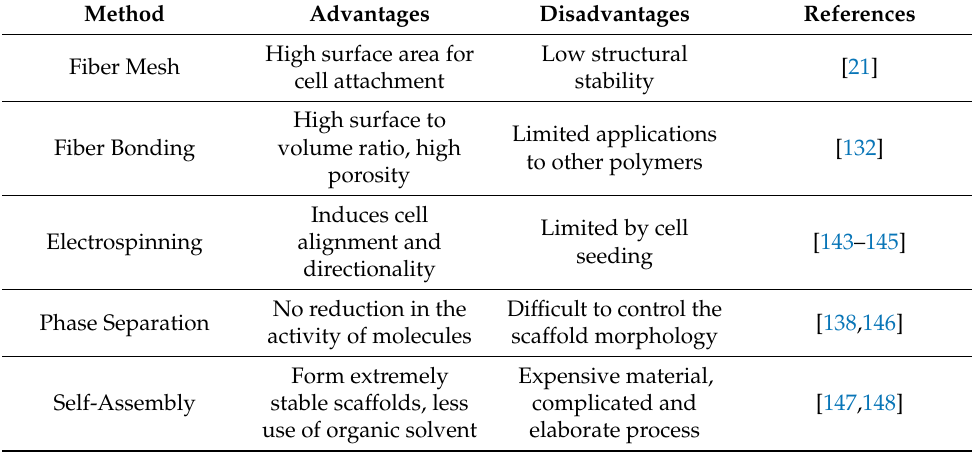
Table 4. Fabrication of fibrous scaffolds: advantages and